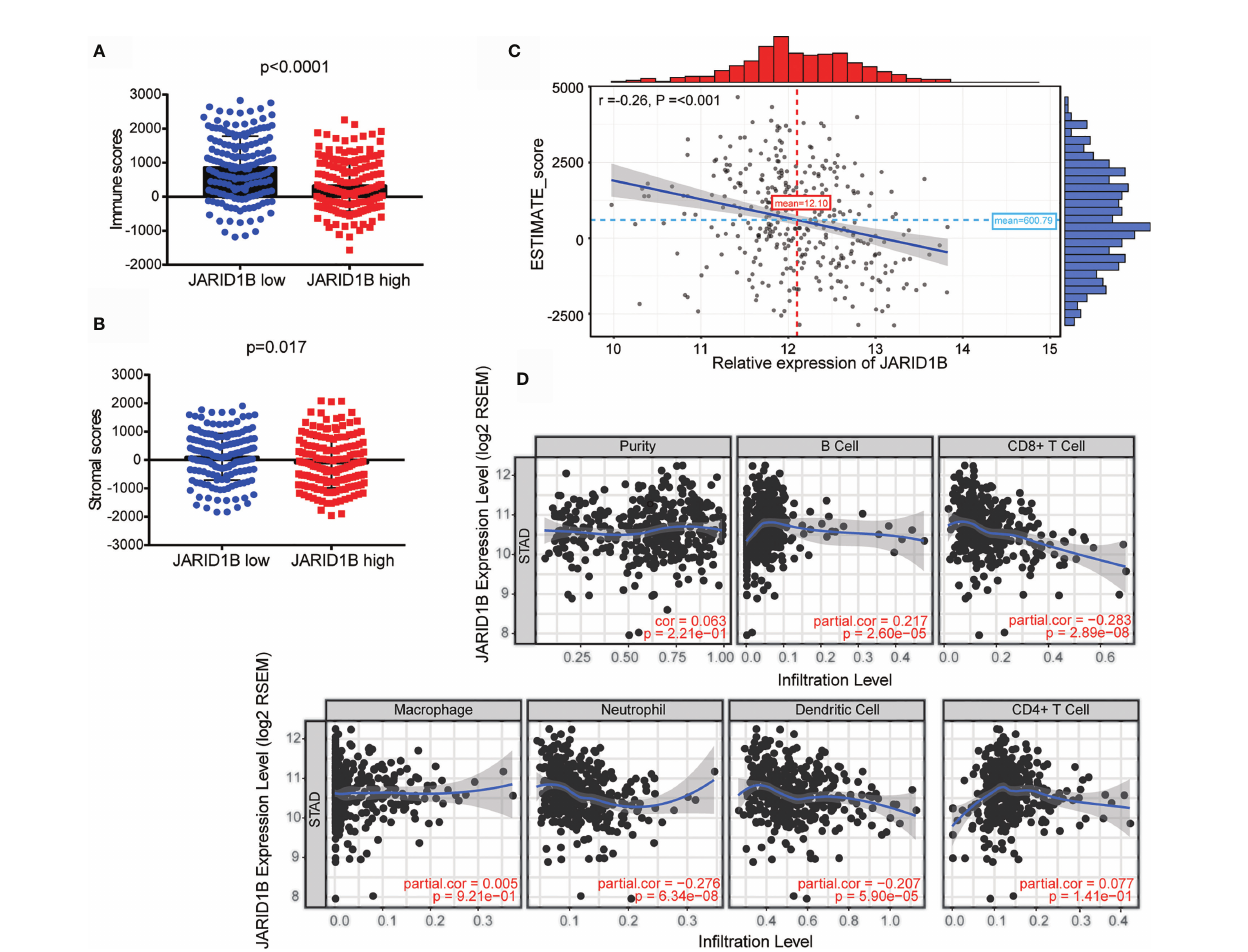
FIGURE 2 | JARID1B overexpression is associated with greater tumor purity and immune in fi ltration of gastric cancer (GC). (A, B) Relationship between JARID1B expression and the immune score, stromal score group in TIMER of GC. (C) Correlation between JARID1B expression and ESTIMATE score in TIMER of GC. (D) Correlation between JARID1B expression and CD8+ T cells, neutrophils, as well as dendritic cells in TIMER of